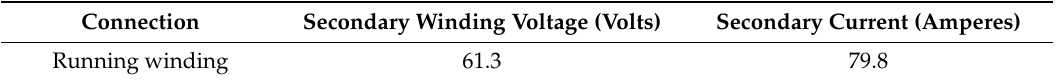
Table 6. Output of the welding transformer.